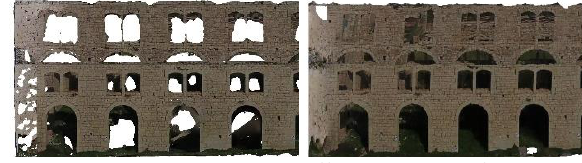
Figure 22. Comparison among different elevations from